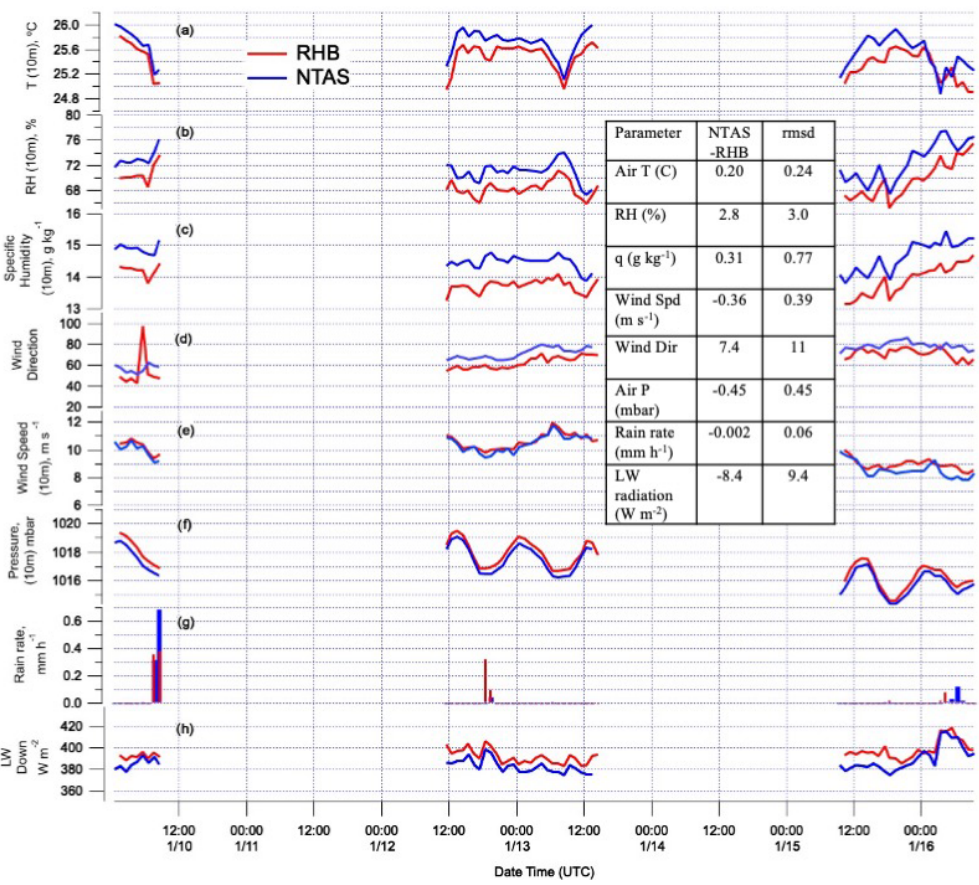
Figure 6. Comparison of meteorological parameters measured on board the NTAS buoy and the RV Ronald H. Brown ( RHB ) when the platforms were between 0.25 and 3nmi apart between 10 and 15 January including (a) atmospheric temperature (10m), (b) relative humidity (10m), (c) specific humidity (10m), (d) wind direction, (e) wind speed (10m), (f) atmospheric pressure (10m), (g) rain rate, and (h) longwave downwelling radiation. The averages of absolute differences (NTAS − RHB ) and root mean square differences (RMSDs) are reported in the inset table. Number of samples based on 1h averaged data =